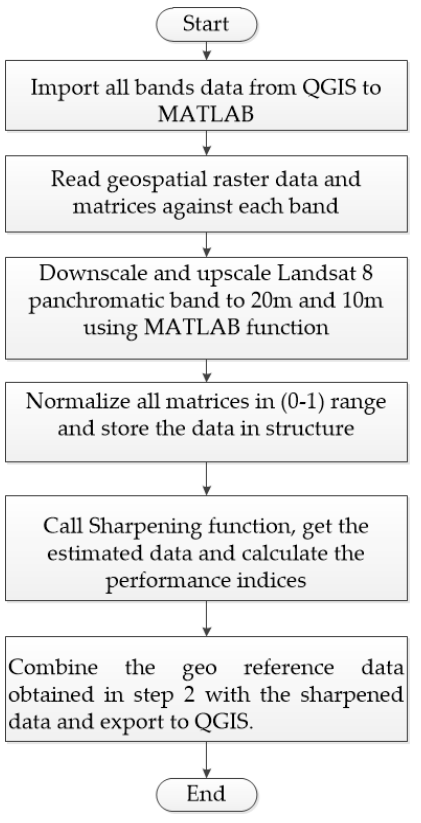
Figure 2. Flowchart explaining how to link QGIS and MATLAB for image sharpening.